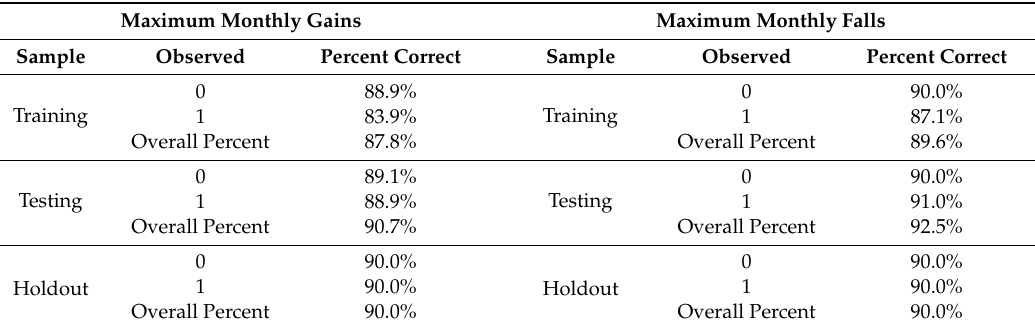
Table 7. Network classification for GSE maximum monthly gains and